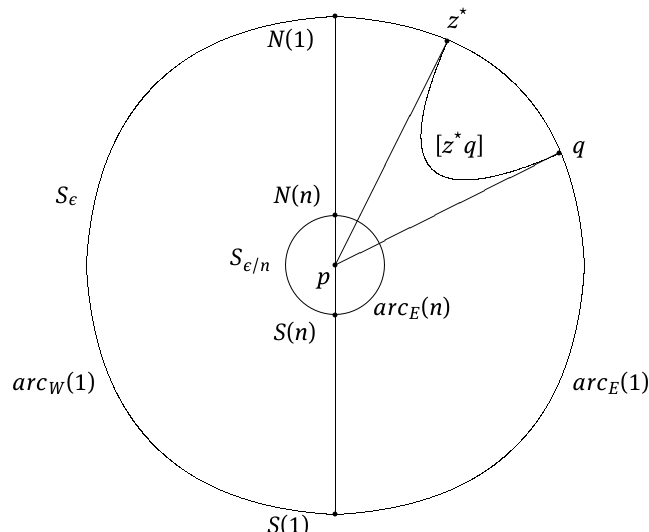
Figure 2: A geodesic configuration which cannot occur if S ϵ / n is not rectifiable.